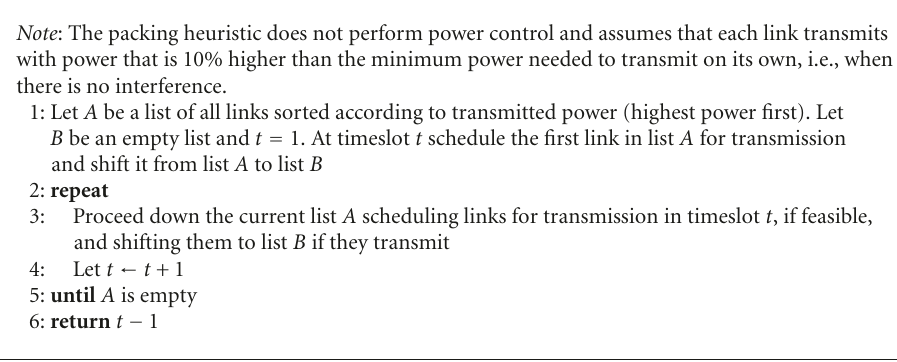
Algorithm 3: Packing